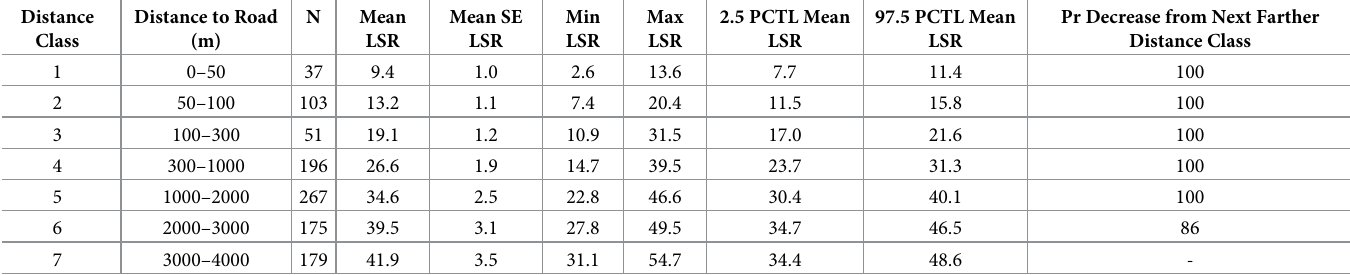
Table 5. Lichen species richness (LSR) model summarized by distance class from the DMTS haul road in CAKR. Summarization methods for mean, standard error (SE), minimum, maximum, 2.5 percentile, 97.5 percentile and probability of decrease (Pr Decrease) follow those used in Neitlich et al. [17] for contaminants. The probabil- ity of decrease (Pr Decrease) reports the percentage of decreases in the comparisons of the 200 posterior predictions of each adjacent distance class. Distance Distance to Road Class (m)